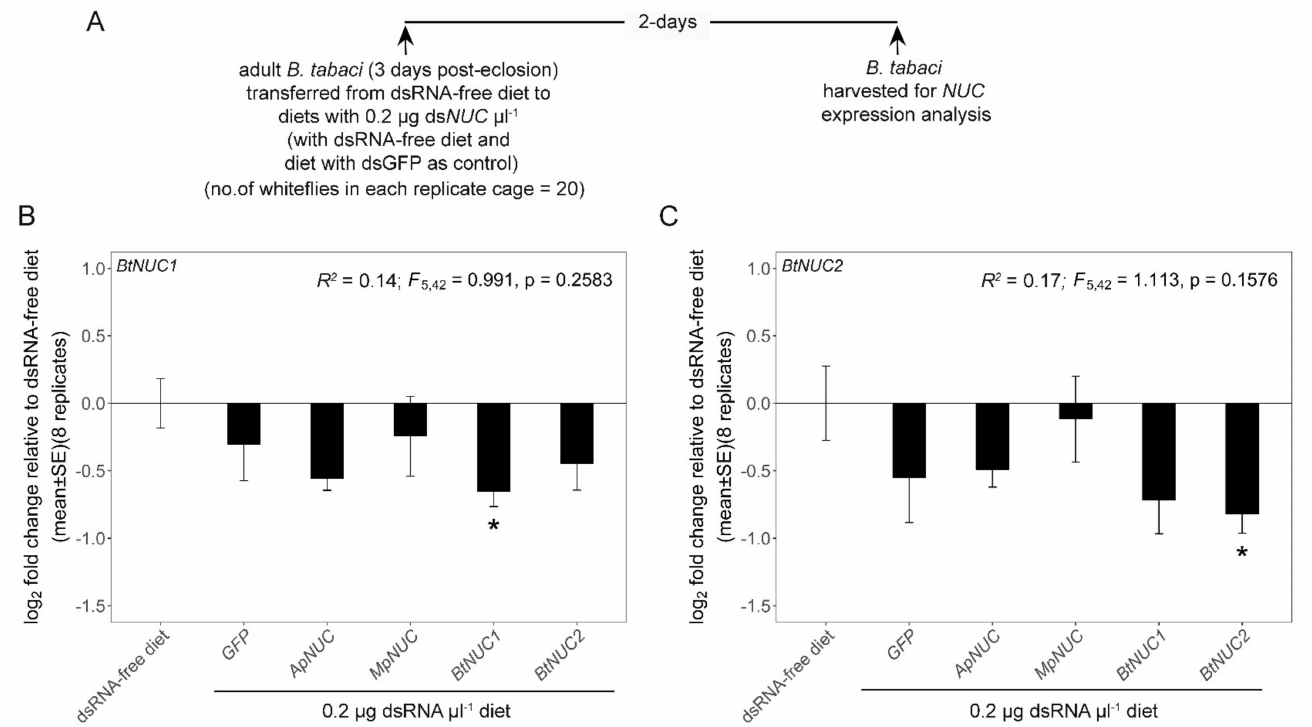
Figure 5. Activity of aphid ds NUC against expression of B. tabaci NUC genes. ( A ) Experimental design. ( B ) B. tabaci NUC1 gene expression and ( C ) B. tabaci NUC2 gene expression. Pooled data for two iterations, each iteration comprising four replicate cages for each treatment, are shown. Linear model statistics were employed using dsRNA-free diet as the intercept to identify significant effects of various dietary dsRNAs on NUC expression. Asterisks identify treatments that are significantly different from ds GFP -free diet at α = 0.05. ApNUC , A. pisum NUC ; BtNUC1 , B . tabaci NUC1 ; BtNUC2 , B . tabaci NUC2 ; MpNUC , M. persicae NUC